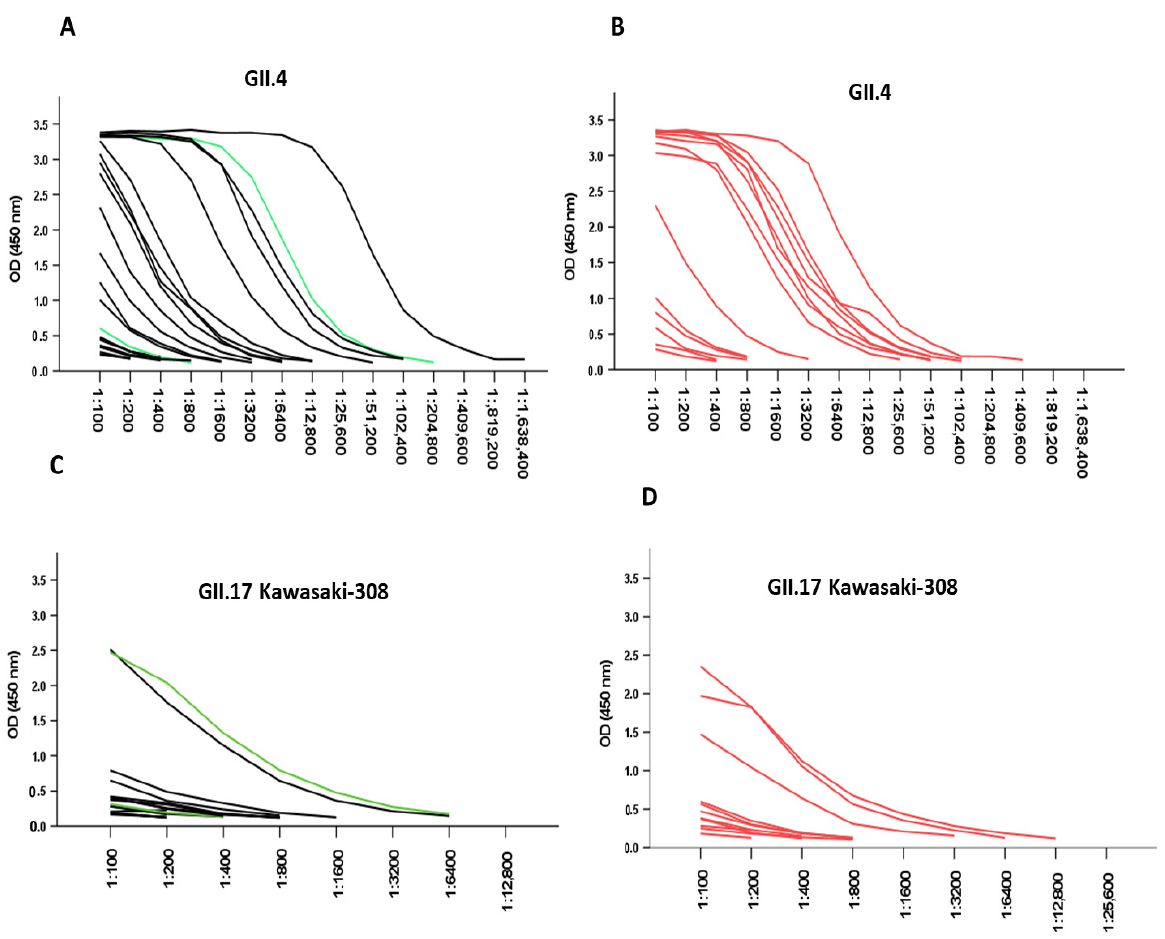
Figure 2. NoV IgG titration curves in serum samples from acute infections. ( A ) Sera from children with GII.4 Sydney/2012 (black lines, n = 21) and GI.2 genotype (green line, n = 2). ( B ) Other GII genotypes (red lines, n = 14) were titrated with two-fold serial dilutions, and IgG antibodies were analyzed against GII.4 Ni 1315 and GII.17 Kawasaki-308 genotypes. For GII.17 Kawasaki-308, ( C ) black lines, n = 17; green lines, n = 2; and ( D ) red lines, n = 12.